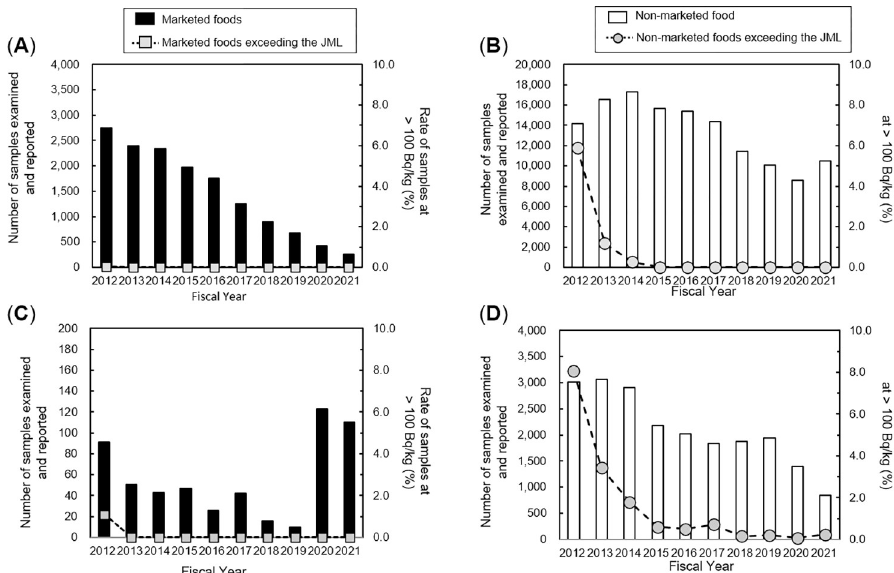
Fig 3. Results on Cs concentration data analyzed for fishery foodstuffs. Annual trends of marketed and non- marketed marine fishery foodstuffs (A and B, respectively) or marketed and non-marketed freshwater fishery foodstuffs (C and D, respectively) reported as exceeding 100 Bq/kg. All data reported using a GE semiconductor detector in the database were included in the analysis.